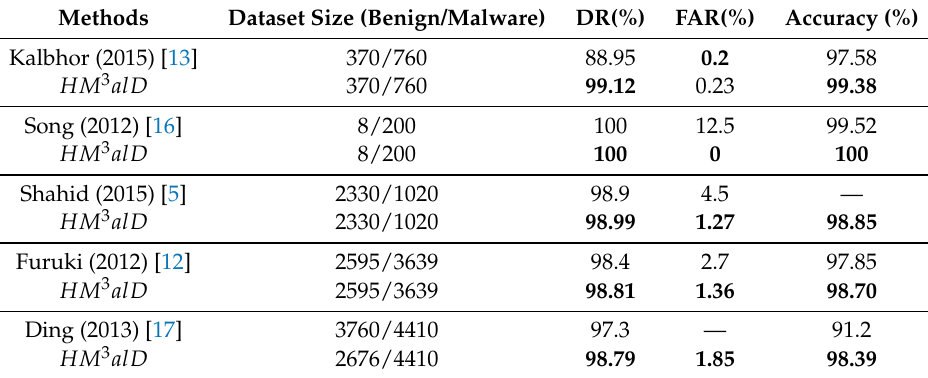
Table 5. Comparison of HM 3 alD with the current static malware detection